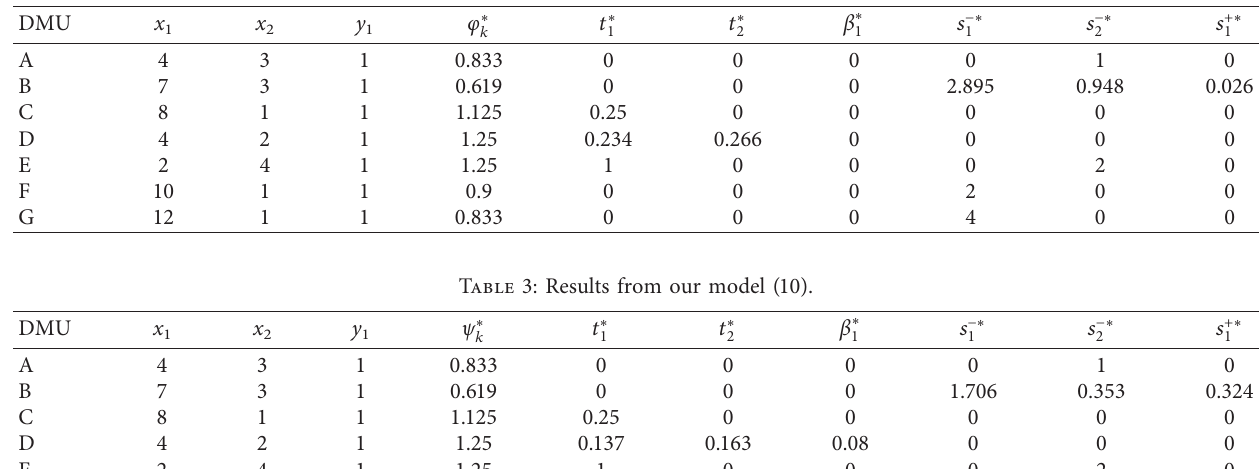
Table 2: Results from J-SBM model (6).